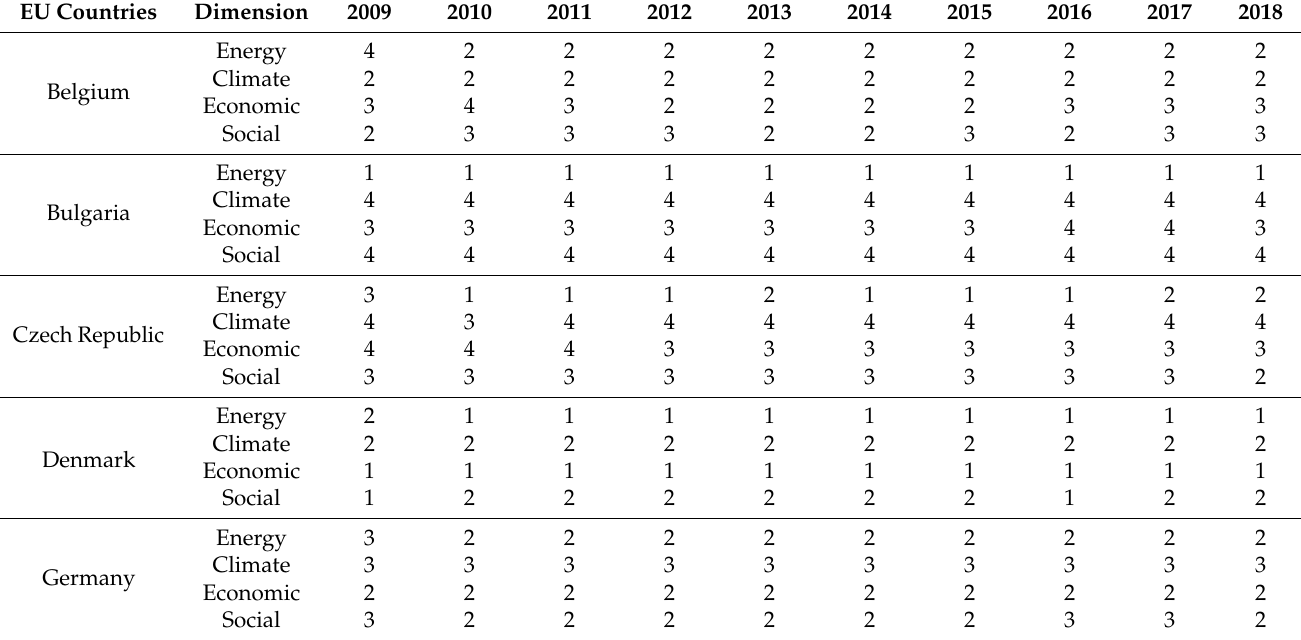
Sweden). Table 4. The level of the EU development in individual dimensions of energy and climate sustainable development between 2009–2018. EU Countries